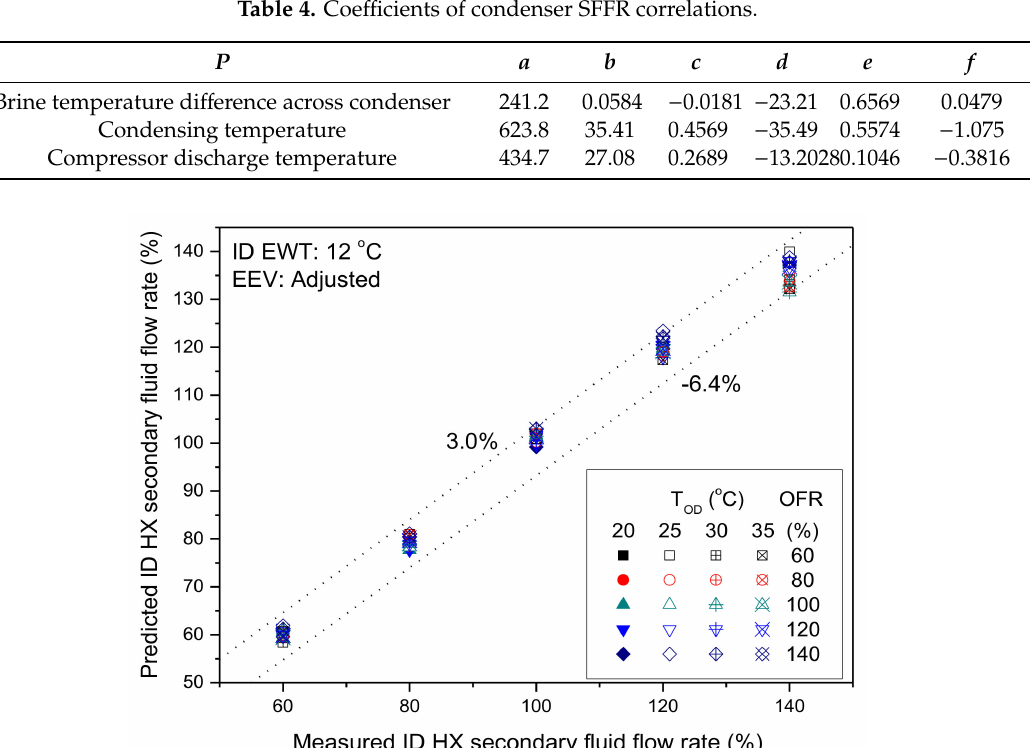
Figure 14. Comparison between predicted and measured evaporator SFFR using MSSFF